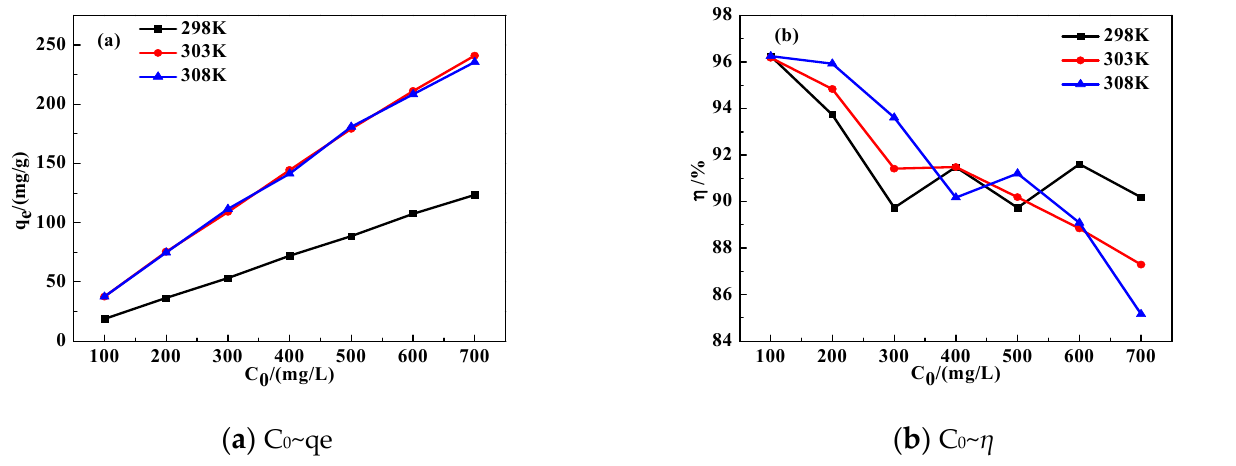
Table 3. Adsorption kinetic model parameters of Pseudo-first kinetic model pseudo-second kinetic model and intra-particle diffusion kinetic mode.